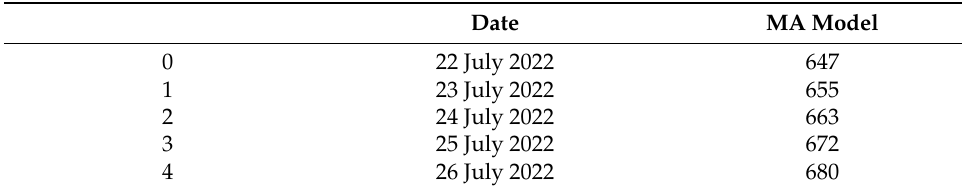
Table 6. MA model confirmed case prediction over five days.